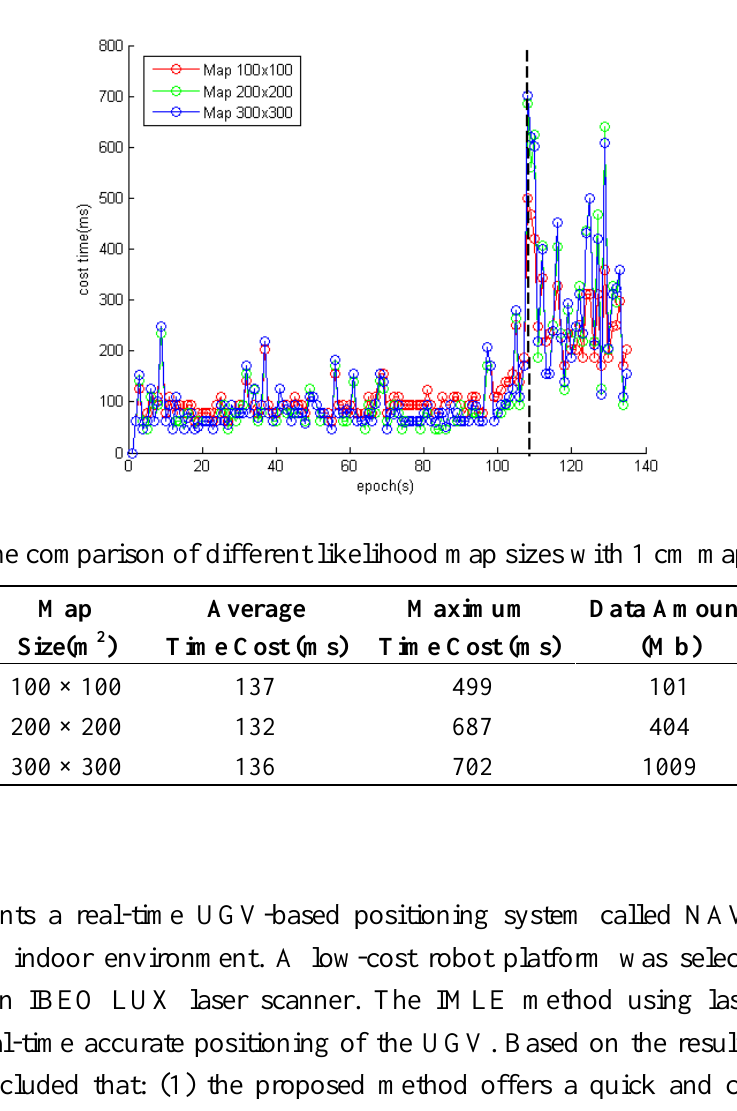
Figure 13. The time cost of each scan matching with different likelihood map sizes.